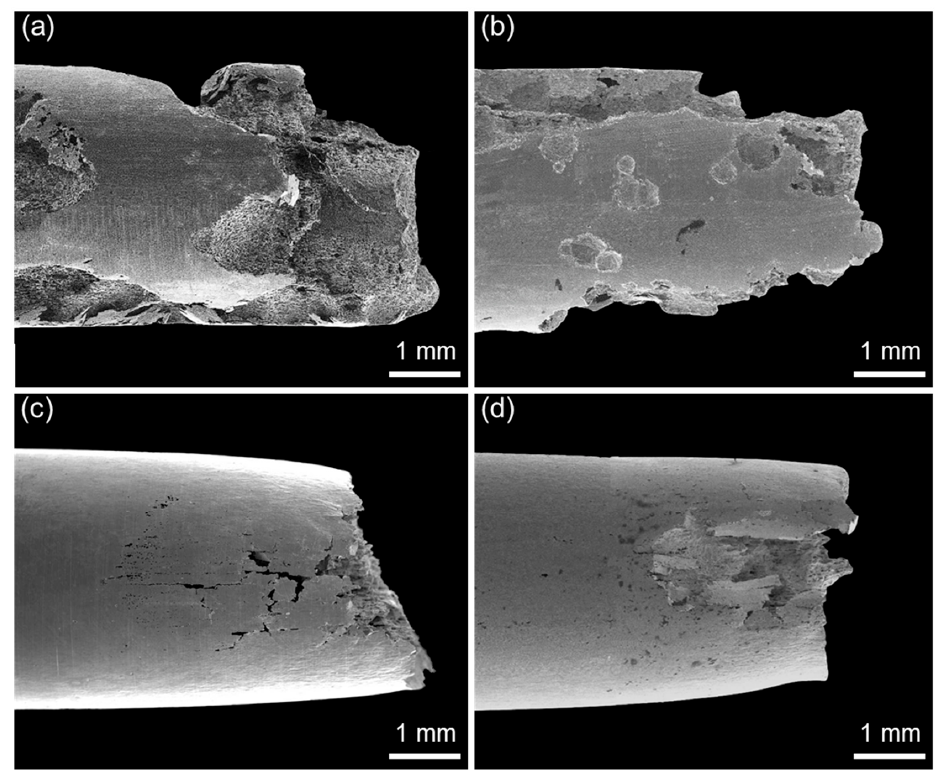
Figure 8. SEM micrographs of the side surfaces of ( a , b ) D1 and ( c , d ) D2 alloys after the SSRT conducted in 2 M NaCl solution at 50 °C under anodic applied potential of +0.05 V versus E corr at a strain rate of 10 − 6 s − 1 . The SSRTs were conducted along ( a , c ) L- and ( b , d ) T-directions.